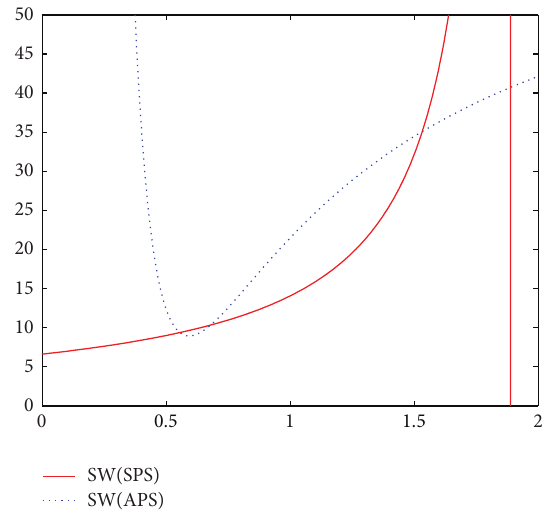
Figure 11: Social welfares with product subsidies.